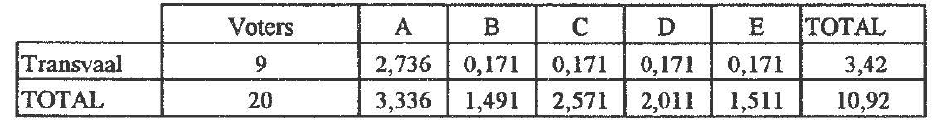
Table 3: An exceptional voting pattern in Transvaal